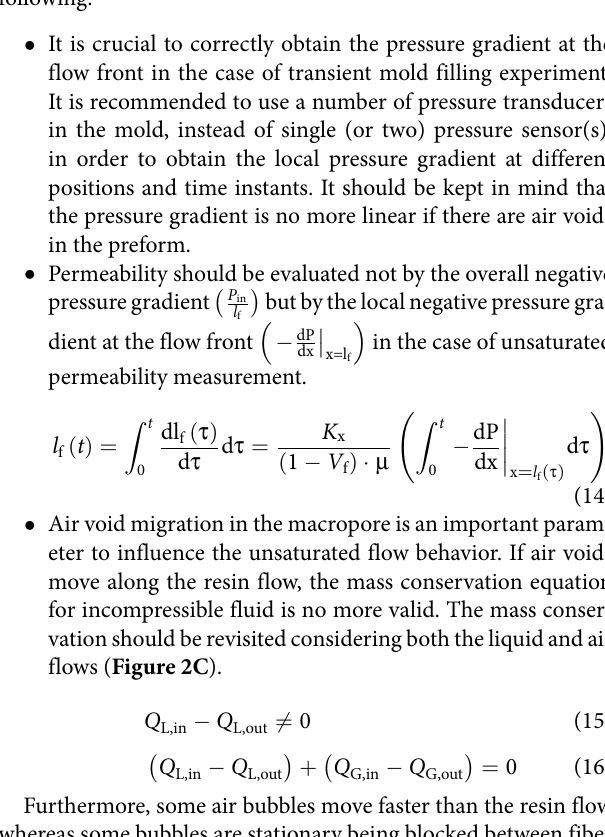
FIGURE 2 | Schematic of liquid (L) and air (G) flows for the investigation of mass conservation condition . (A) Saturated flow. (B) Unsaturated flow with intra-bundle voids. (C) Unsaturated flow with inter-bundle